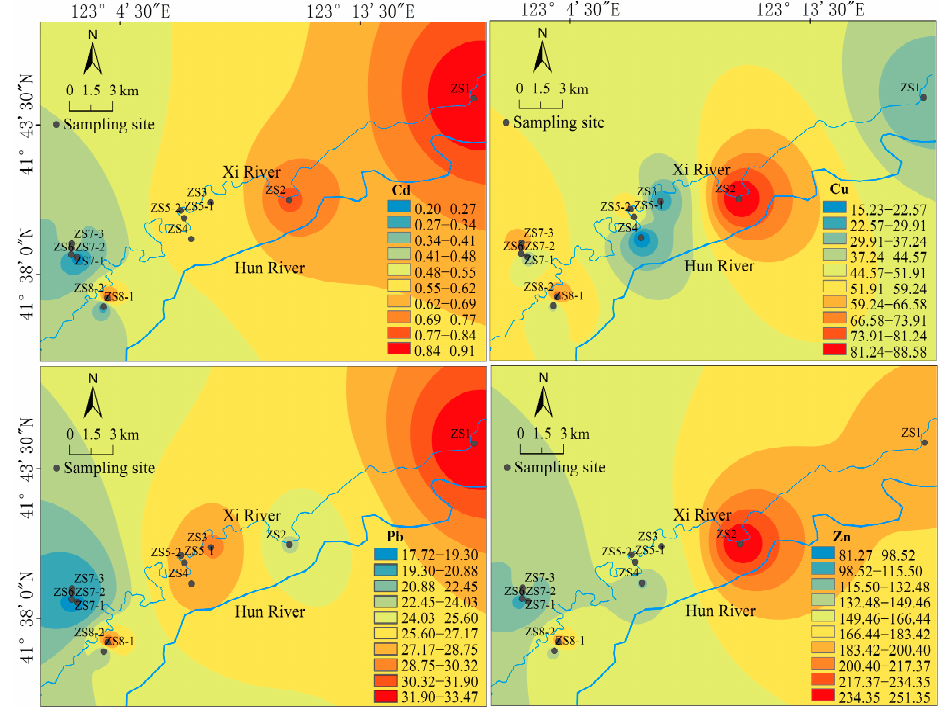
Figure 2. Spatial distributions of Cd, Cu, Pb, and Zn in soils of the study area (mg·kg − 1